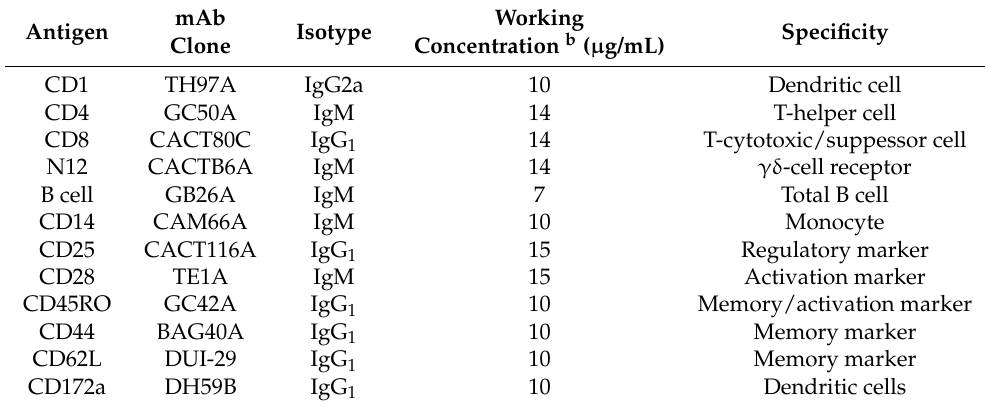
Table 1. Primary antibodies used in flow cytometry experiments a